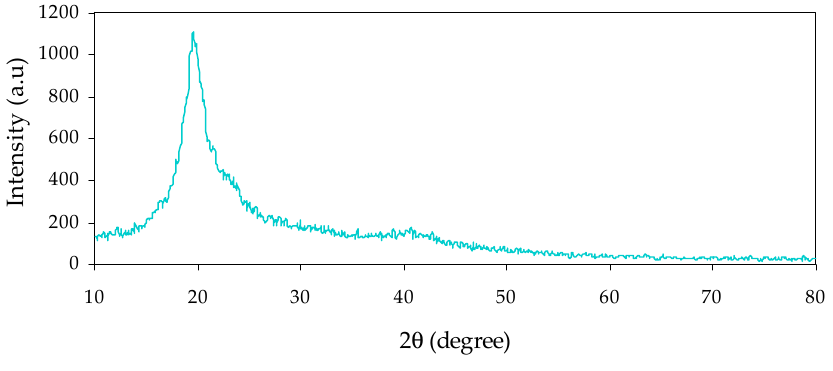
Figure 1. XRD pattern of neat PVA film.